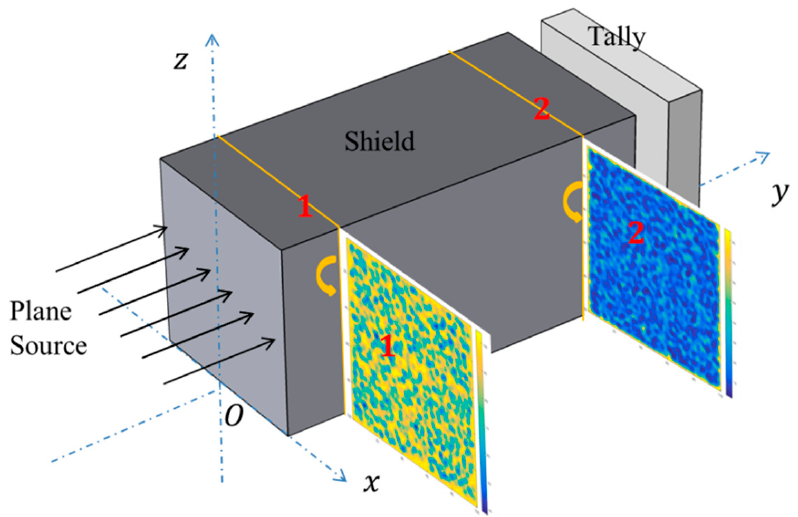
Figure 5. The entire calculation model (surface 1 and surface 2 are on the x-z plane for neutron flux distribution).